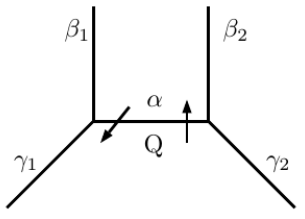
Figure 12: ( − 2,0 ) curve with both inner edges in the canonical